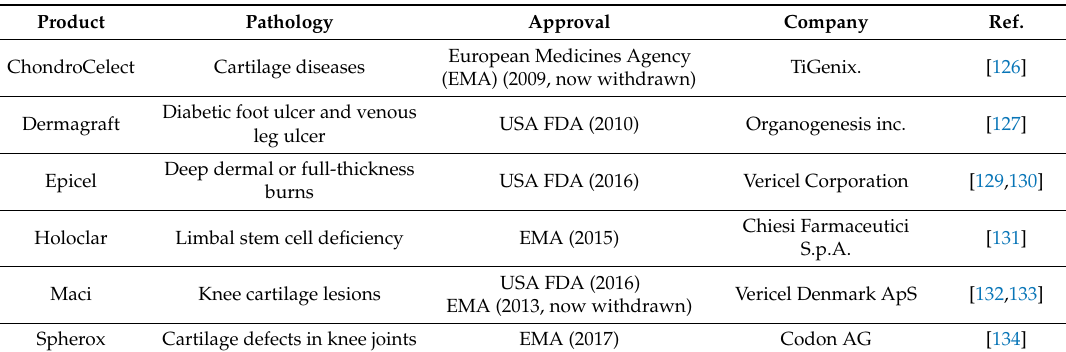
Table 4. List of tissue engineering therapeutic approaches used in